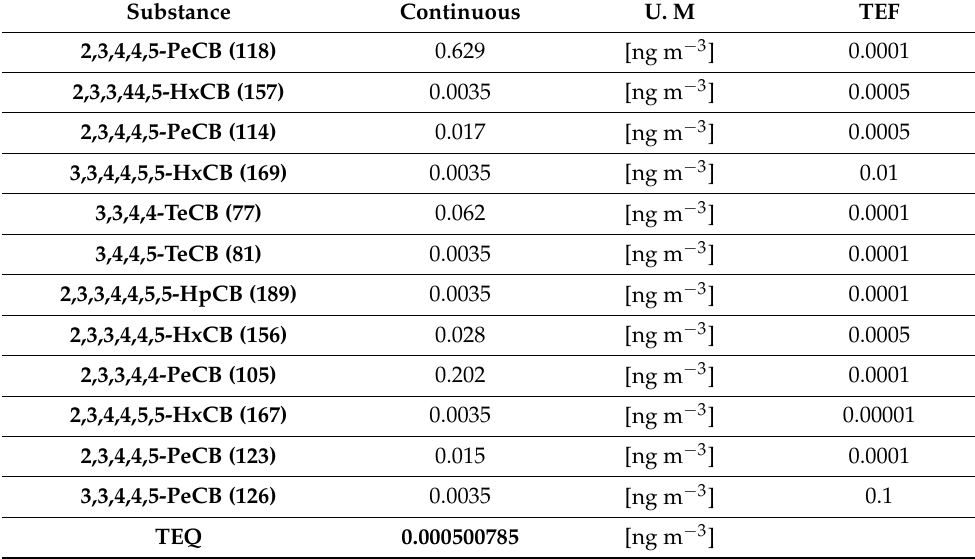
Table 10. PCB concentration and